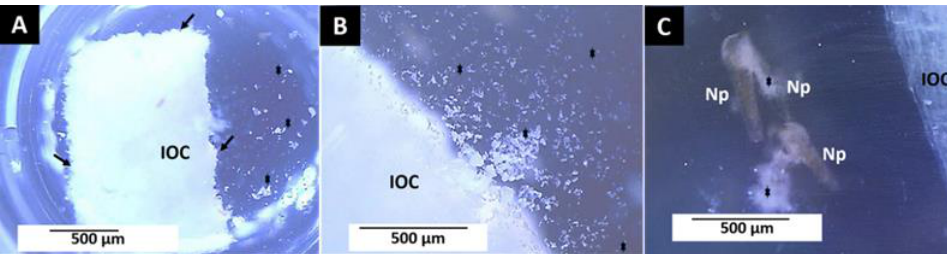
Figure 7. Material F2 (InterOss Collagen) at 24 and 48 h in a seawater solution with Artemia salina . ( A ) Material at 24 h. Image at 1×. ( B ) Material at 48 h. Image at 3×. ( C ) Material at 48 h. Image at 4×. IOC: Material. Np: Nauplii. Stars: Detached material. Stereoscopic microscope technique. IOC: Material. Black arrow: areas of material degradation. Red arrow: Fragments of the detached material.